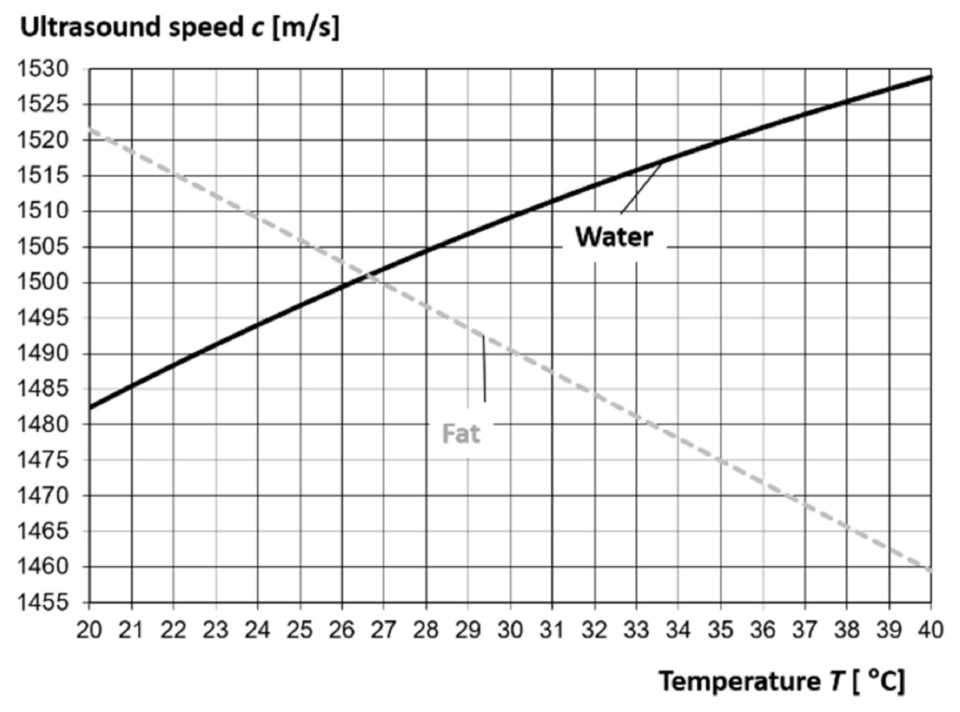
Figure 6. Temperature dependence of ultrasound velocity in water and